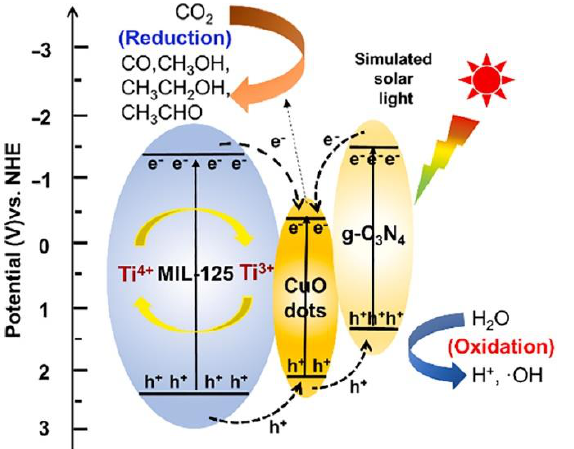
Schematic illustration of photoexcited electron–hole separation process over g- C 3 N 4 /CuO@MIL-125(Ti). Reproduced with permission from reference [63].